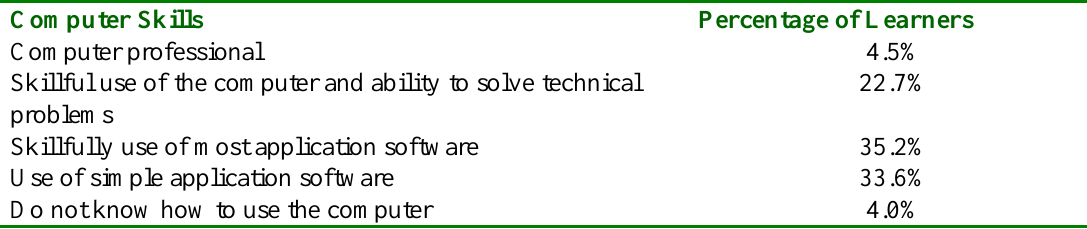
Table 12. Computer skills of the learners prior to enrollment Computer